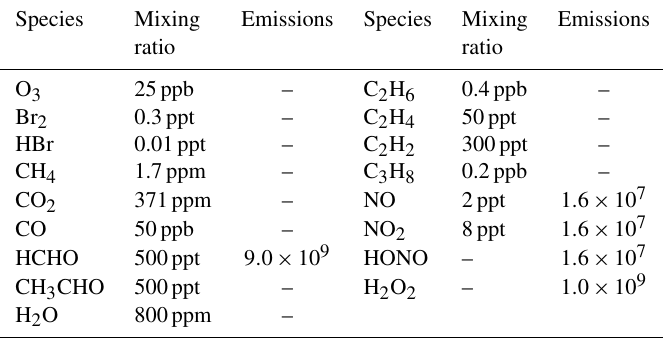
Table 2. Initial atmospheric composition in the boundary layer of the Antarctic (ppm = parts per million, ppb = parts per billion, ppt = parts per trillion) (Piot, 2007), and the prescribed intensities of emission fluxes from the ground surface (units: molec.cm − 2 s − 1 ) (Hutterli et al., 2004; Riedel et al., 2005; Jones et al., 2011), assumed in the